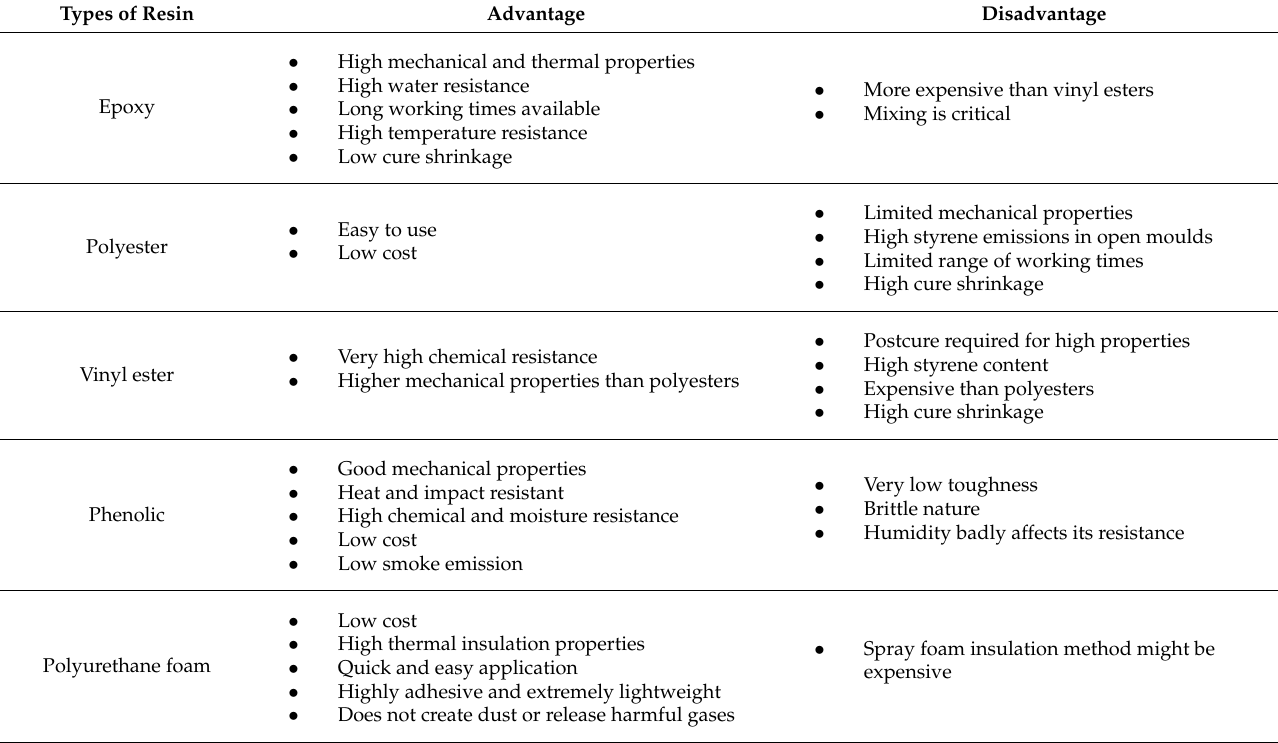
Table 1. Advantage and Disadvantage of Different Resins